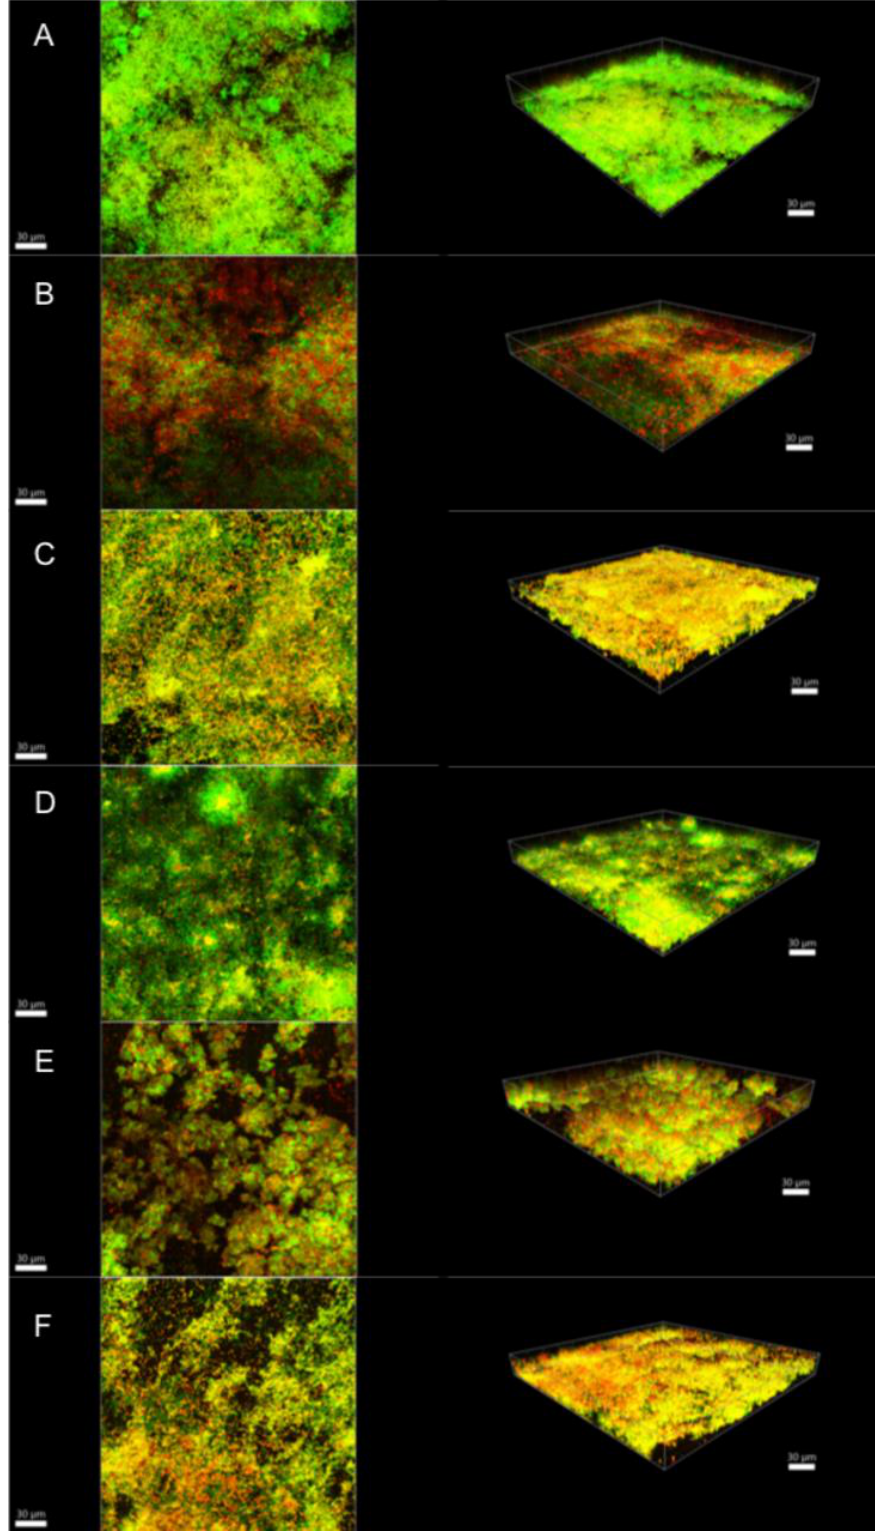
Figure 4. Confocal laser scanning microscopy images of 21-day biofilms. ( A ) saline; ( B ) 1.5% NaOCl; ( C ) 17% EDTA; ( D ) high-purity nisin; ( E ) 1.5% NaOCl + high-purity nisin and ( F ) 17% EDTA + high-purity nisin. The biofilms were stained using the LIVE/DEAD Viability Kit; live cells appear green and dead cells red. Images represent the 3D reconstructions of the biofilms using IMARIS 7.6.5 software (orthogonal and perspective views from left to right). Scale bar 30 μm.